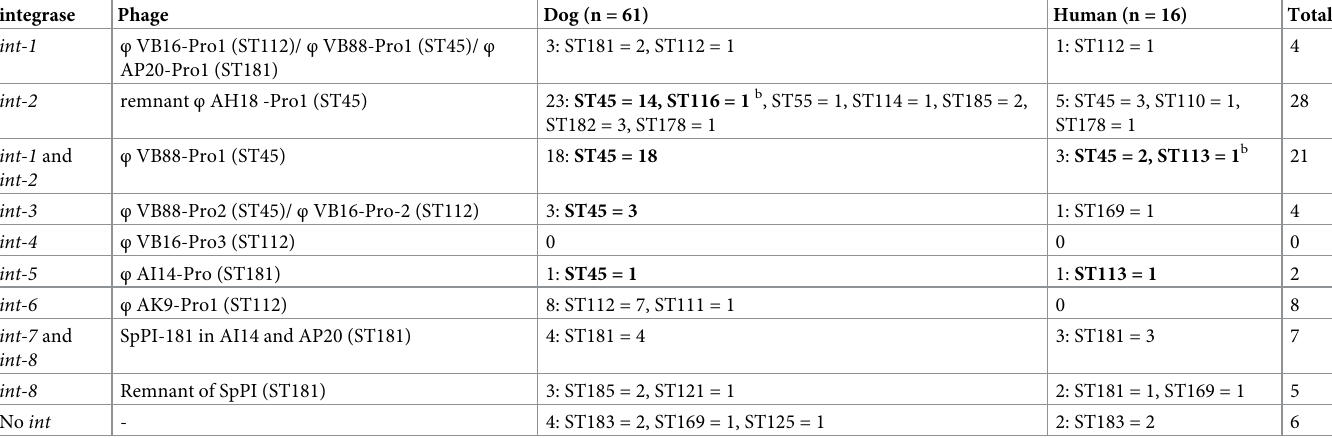
Table 2. Integrase of prophages and SpPI detected in 77 MRSP isolates belonging to different sequence types (ST) a .